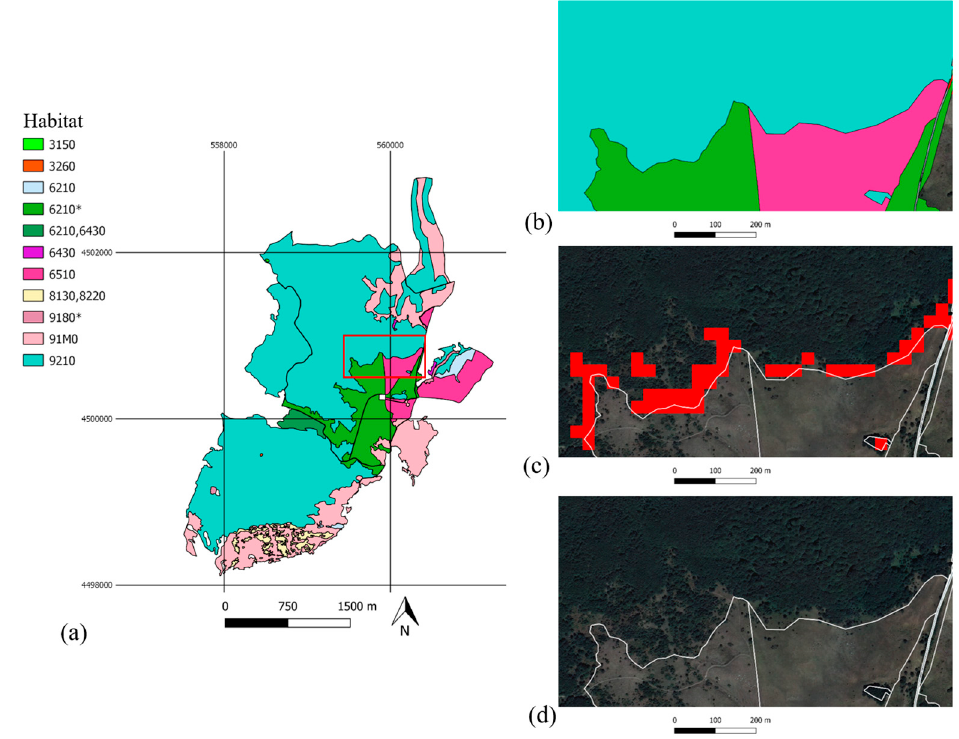
Figure 3. Contrasting features of adjacent habitats within the Monti Li Foi SAC: ( a ) Map of habitats; ( b ) zoom on the analyzed habitats (red box): 9210 ( Apennine beech forests with Taxus and Ilex ), characterized by wooded vegetation, borders on herbaceous species 6510 ( Lowland hay meadows—Alopecurus pratensis, Sanguisorba officinalis ); ( c ) map of the 2009 anomalies overlapped with the 2008 orthophoto: pixels belonging to the beech forest and falling at the border between the two habitats are almost all marked as degraded, ( d ) 2008 orthophoto without overlap.